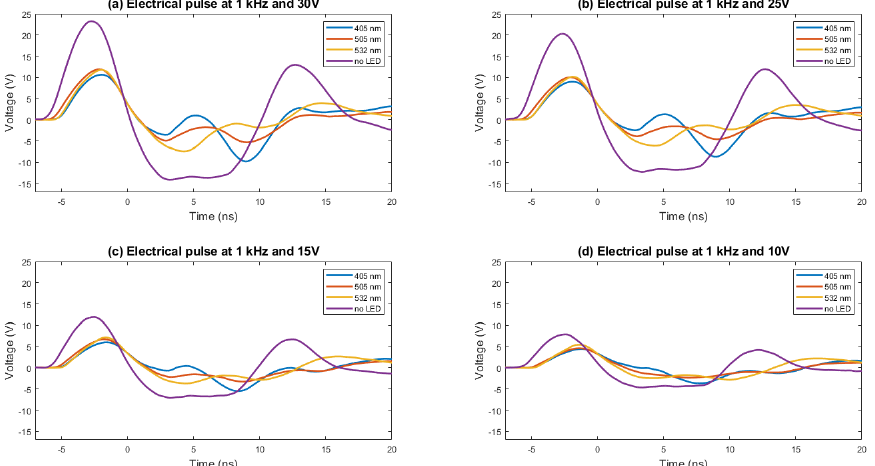
Figure 9. The electrical pulse is obtained with LEDs of 405, 505, and 532 nm. The electrical pulse without LED is also presented. The pulses in this case are presented by voltage (10 ( a ), 15 ( b ), 25 ( c ), and 30 V ( d )). The impedance of the LED makes the system slow down. The differences in the electrical pulse between LEDs are also due to small differences in the LED impedance. The negative oscillation is caused by the inductor placed in parallel with the LED to reduce the pulse